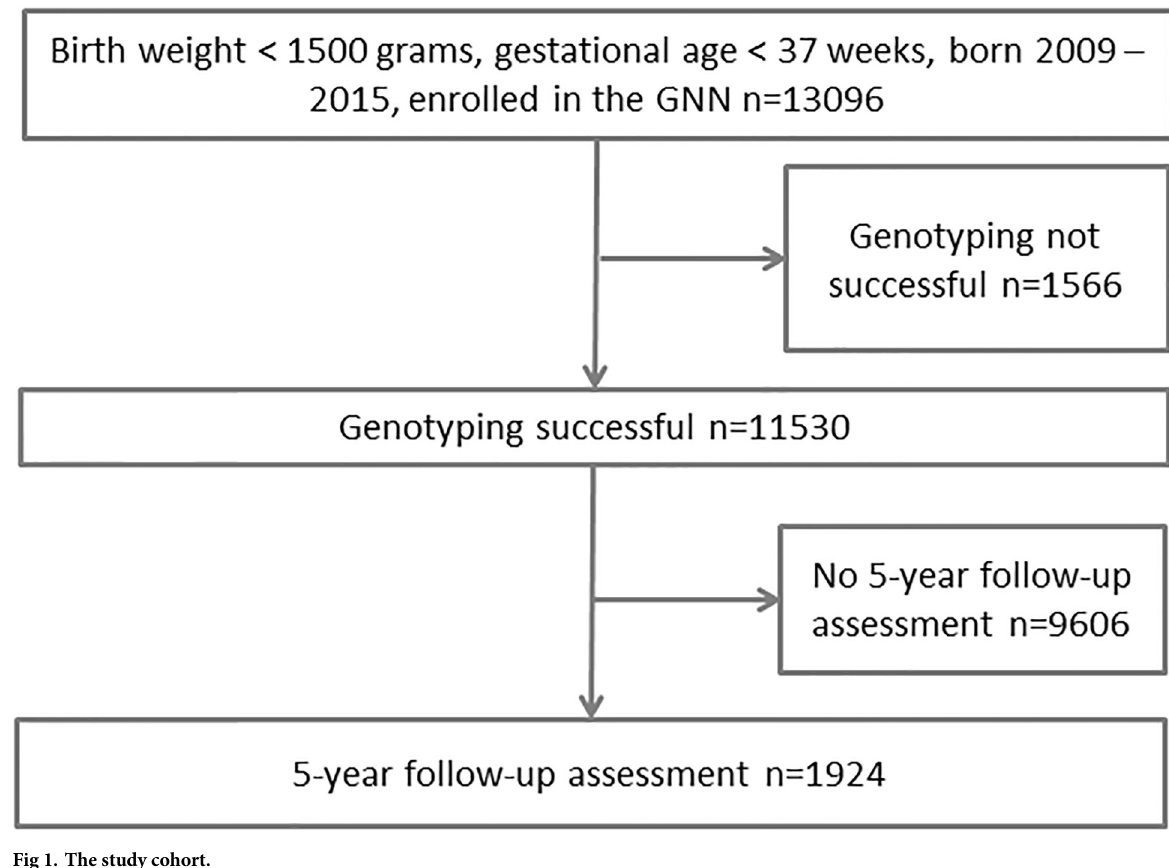
Fig 1. The study cohort.